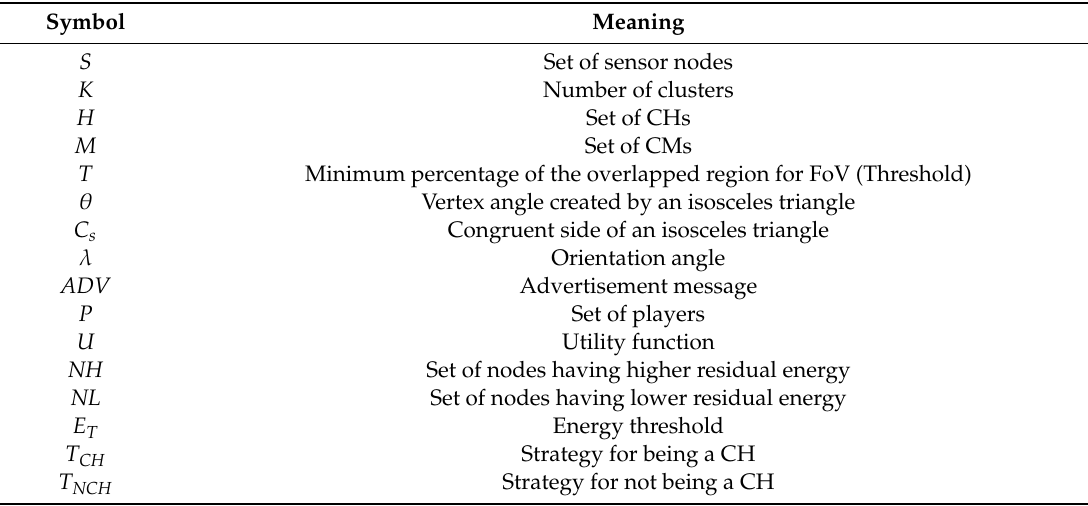
Table 1. Symbols and their